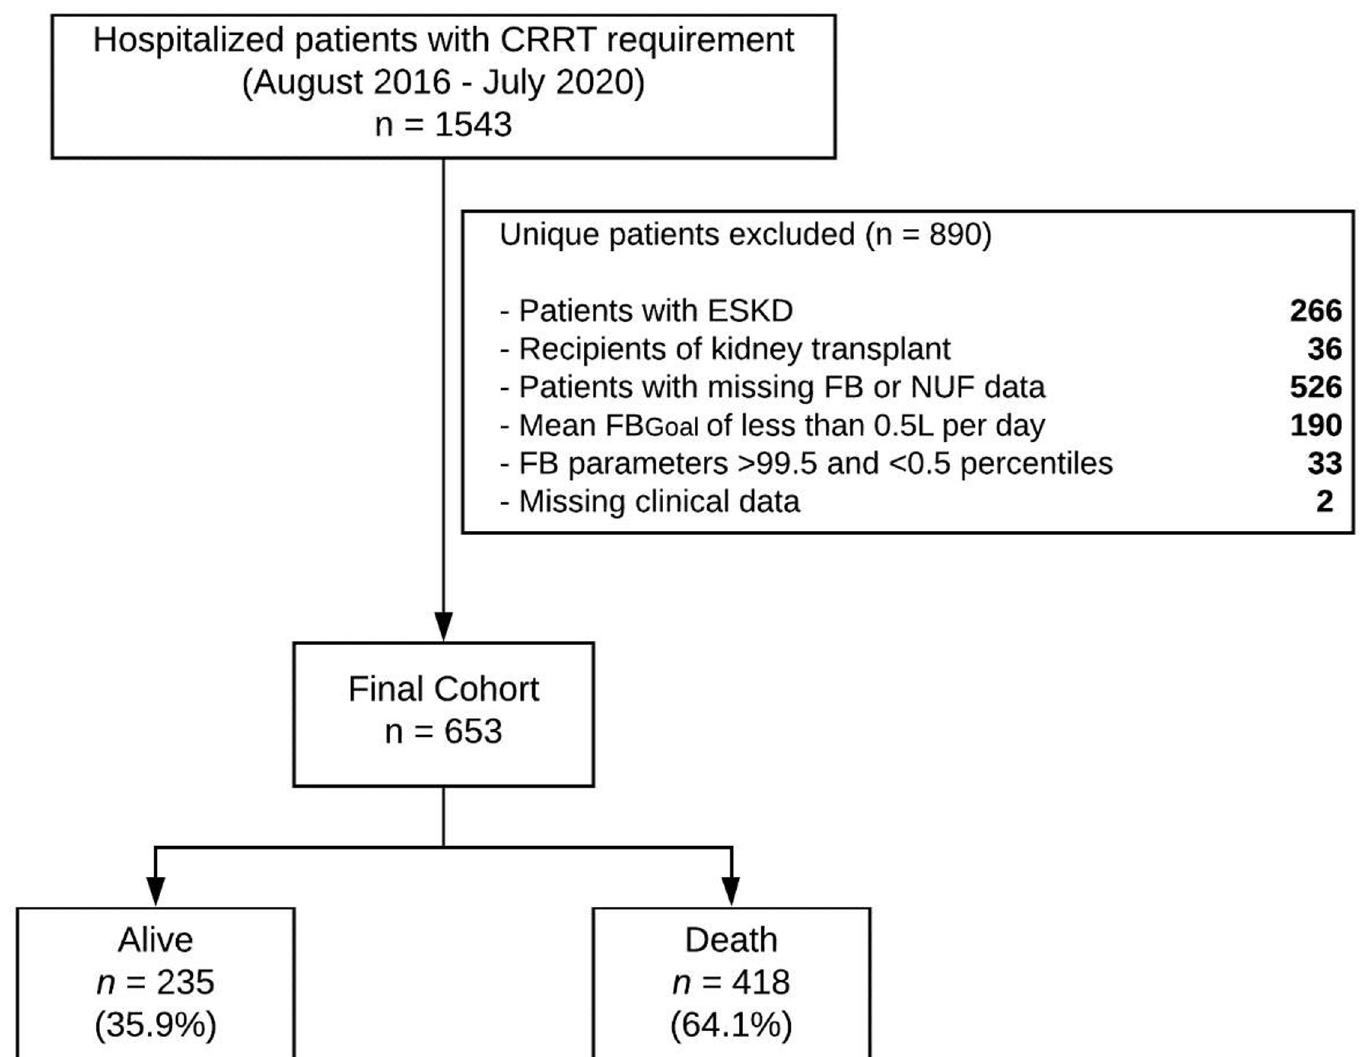
Fig 2. Cohort derivation. CRRT (continuous renal replacement therapy); ESKD (end-stage kidney disease); FB (fluid balance); FB Goal (patient fluid balance goal); NUF (net ultrafiltration rate).